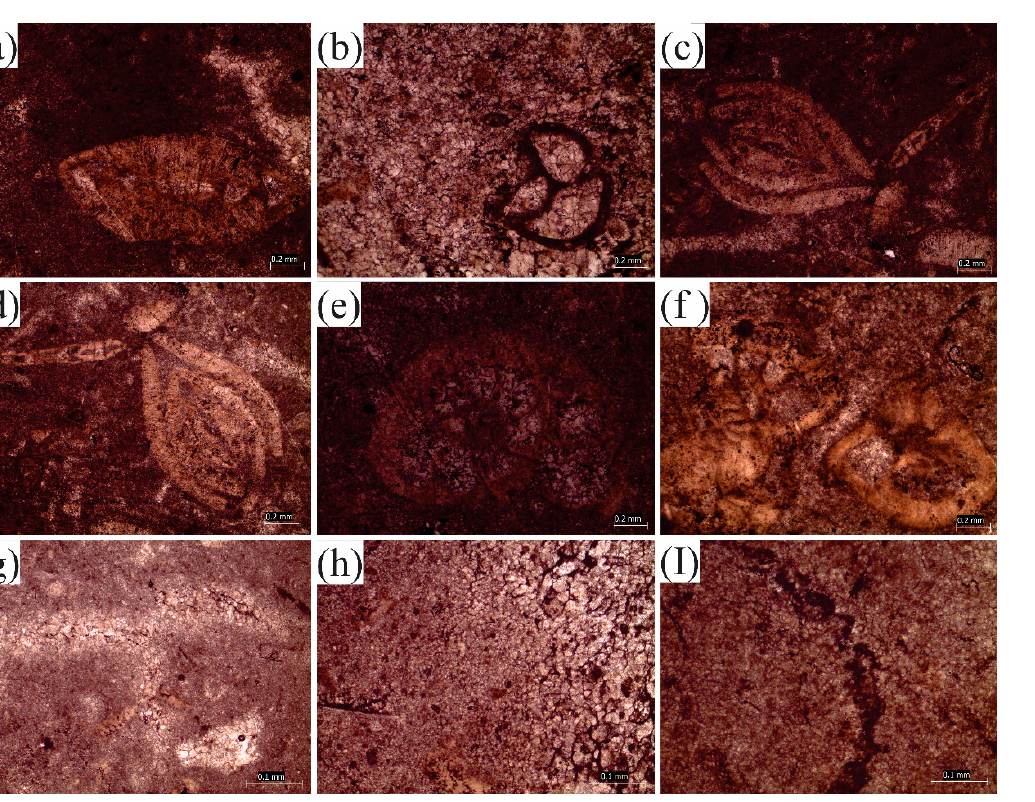
Figure 9. Photomicrographs showing ( a ) Assilina spp.; ( b ) gastropods and geopetal infillings; ( c , d ) Nummulites spp.; ( e ) Operculina spp.; ( f ) Rotalia trochodeformis on the left and Lockhartia tipperi on the right; ( g ) a dolomite patch; ( h ) blocky cement changing into dolomite; and ( I ) micrite changing into dolomite.